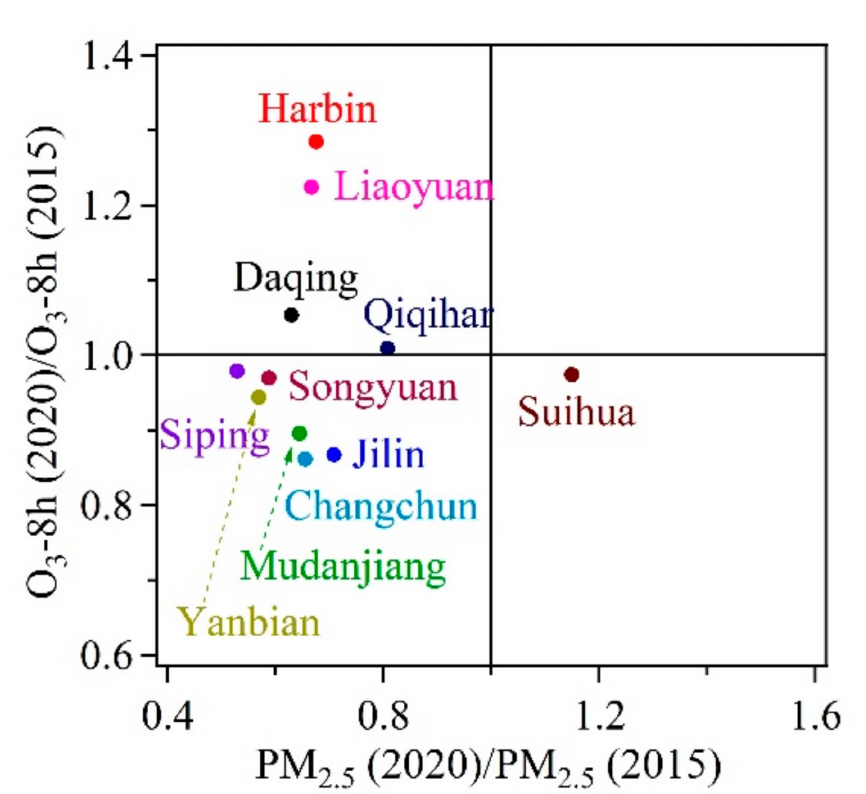
Figure 9. The proportion of the major pollutants during non-attainment periods in the 11 cities of HC.